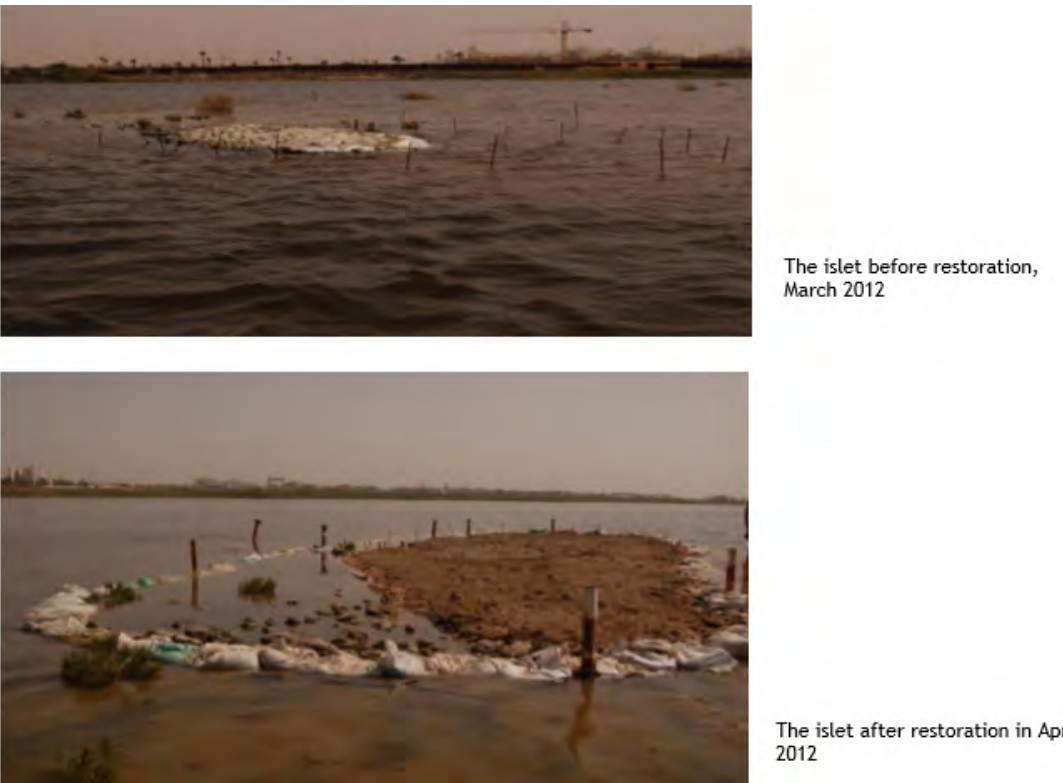
Figure 8. Report on restoration and extension of Lake Jeliana islet.